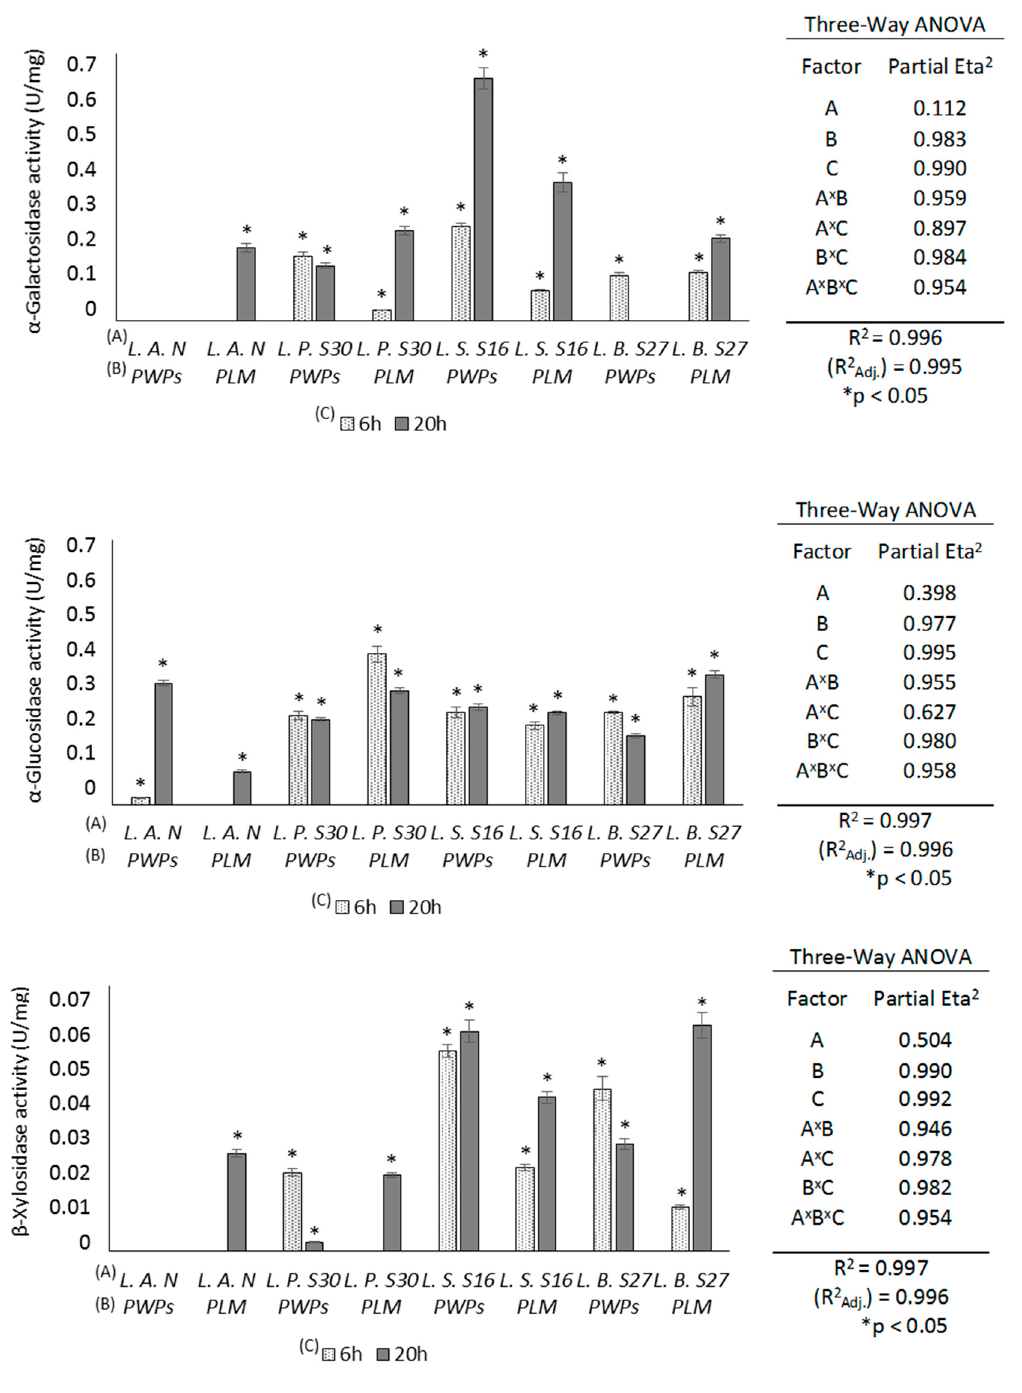
Factors for statistical analysis: ( A ) bacterial strains; ( B ) carbon source; ( C ) time. Figure 5. α -Galactosidase, α -glucosidase and β -xylosidase activity of L. acidophilus N ( L. A. N), L. plantarum S30 ( L. P. S30), L. sakei S16 ( L. S. S16) and L. brevis S27 ( L. B. S27) strains in the presence of